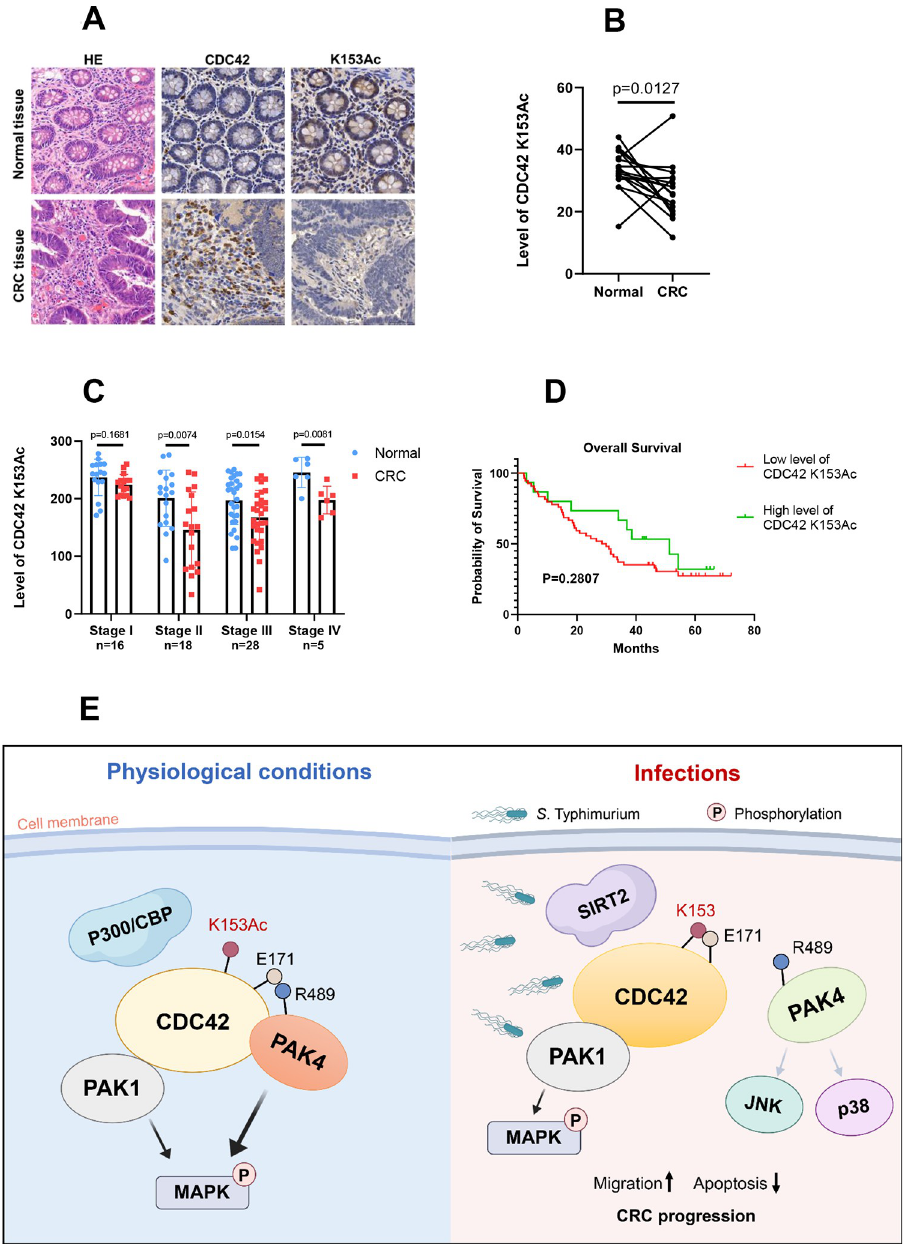
Fig 8. Low level of CDC42 K153 acetylation predicts poor overall survival of patients with CRC. (A) Human CRC specimens were confirmed by HE staining, and the expression levels of CDC42 and CDC42 K153 acetylation and the localization of bacteria in tissues of 17 human CRC specimens were detected by IHC. CDC42 K153 acetylation level was significantly lower in the colorectal adenocarcinoma tissues than in the adjacent normalcolorectal tissues as determined by IHC. The average of IHC intensity ± SD were quantitated by modified H-score from two groups of 17 patient samples (B) and 69 patients with different CRC stages (C) is shown. (D) Kaplan–Meier analysis of overall survival of 69 patients with CRC according to CDC42 K153 acetylation level. (E) Model of CDC42 K153 acetylation effect on colorectal tumorigenesis. Under physiological conditions, acetylated CDC42 K153 can maintain the normal physiological function of cells through MAPK phosphorylation (including ERK, JNK and p38) mediated by the CDC42-PAK4 signaling pathway. When Salmonella infects a host cell, SIRT2 is activated to deacetylate CDC42 K153, which causes an impaired binding of its downstream effector PAK4 and an attenuated phosphorylation of p38 and JNK, consequently reduces cell apoptosis. Moreover,low acetylation level of CDC42 K153 may contribute to the migration and invasion abilities of CRC cells, and promoting tumorigenesis, which may activate tumors mainly through the CDC42-PAK signaling axis.